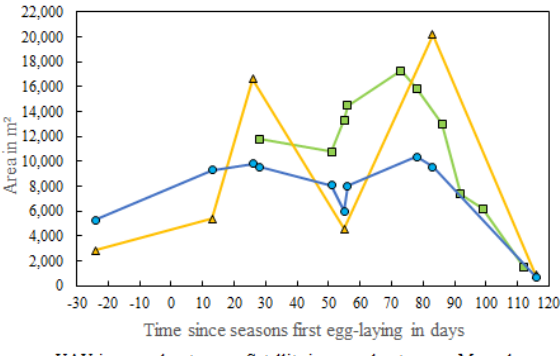
Figure 6. Season 2016/17: different ruleset classification results